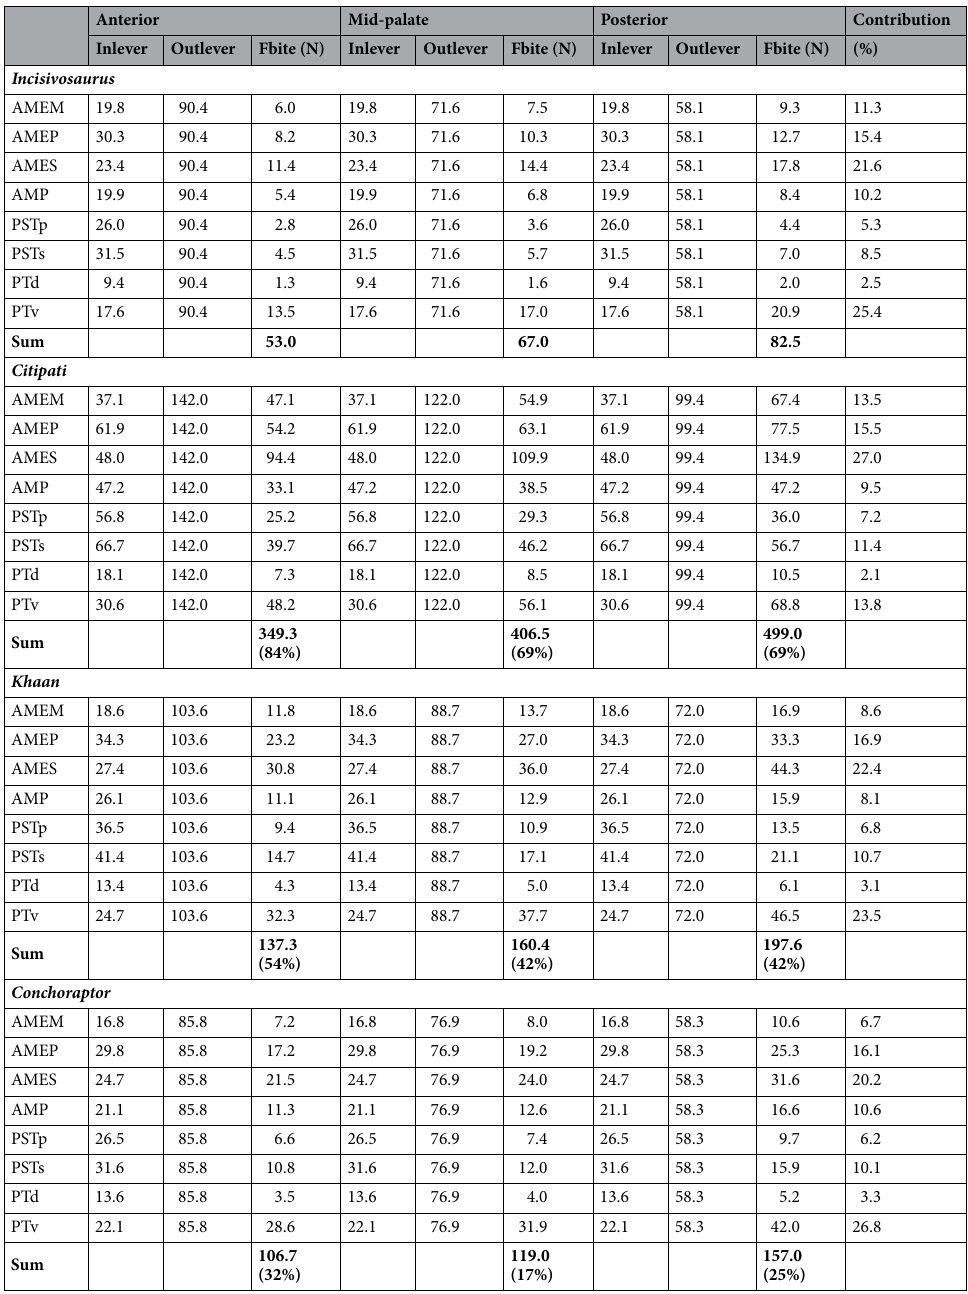
Table 2. Bite force estimates (newtons) for each species, calculated ( Fbite = ( Fres × Linlever ) ÷ Loutlever ) for three points on their primary palate: the anterior tip of the beak/teeth; the middle level of the palate/ toothrow; the tooth-like projection in the posterior of the oviraptorid palate/the posteriormost teeth. Percentages in brackets reported next to the bite force estimates for the oviraptorid taxa show how much greater these estimates are compared to values that would be predicted by scaling up the bite force estimates of Incisivosaurus by cranial surface